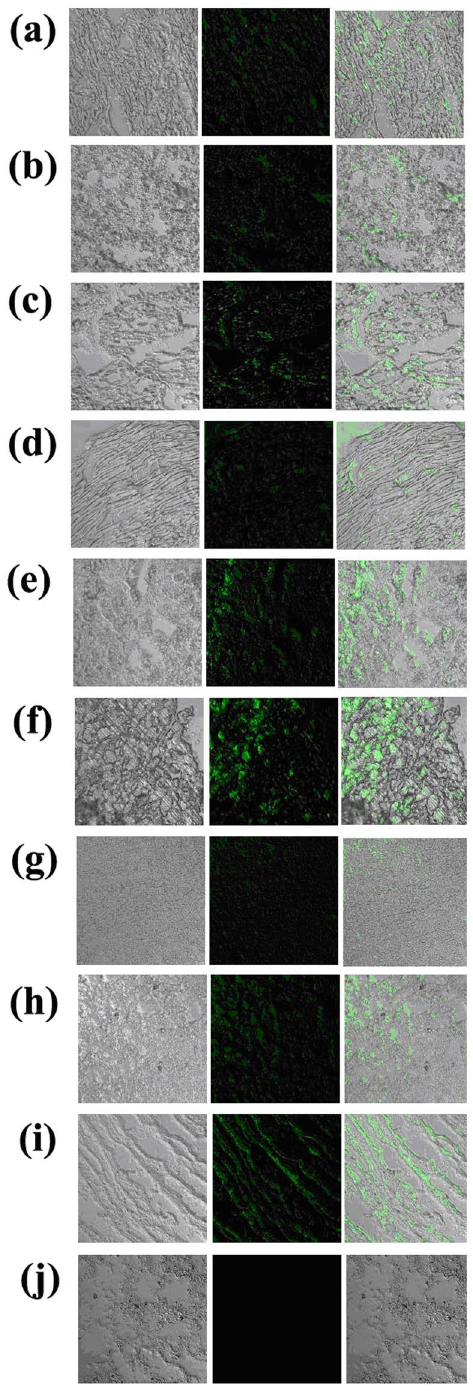
Figure 3. Expression of EGFP in tissues ( × 200) from transgenic cloned calf: heart ( a ), lung ( b ), muscle ( c ), diaphragm ( d ), testis ( e ), fat ( f ), spleen ( g ), kidney ( h ), intestines ( i ) and non-transgenic calf: lung ( j